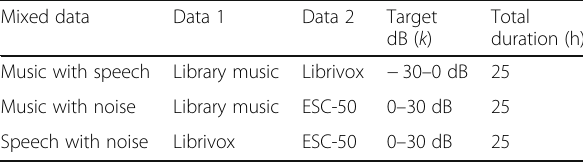
Table 1 Information on mixed